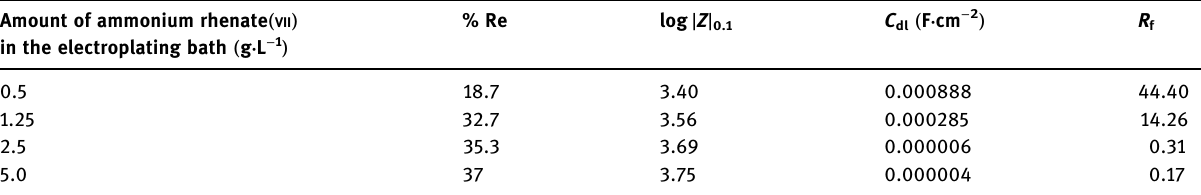
Table 3: Corrosion resistance parameters obtained by the EIS method, depending on the rhenium content in the Ni – Re coating Amount of ammonium rhenate ( VII